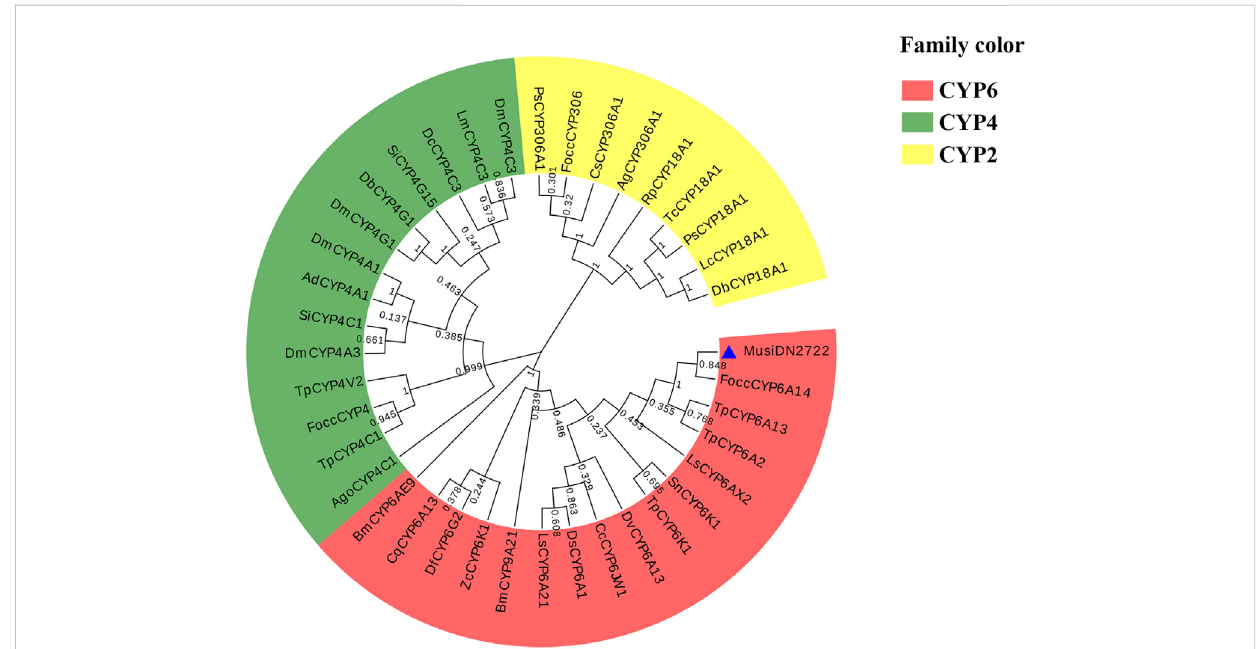
FIGURE 5 Phylogenetic analysis of MusiDN2722 . Focc, Frankliniella occidentalis ; Tp, Thrips palmi ; Sn, Schistocerca nitens ; Cc, Ceratitis capitata ; Ls, Laodelphax striatellus ; Dv, Diabrotica virgifera ; Bm, Bombyx mori ; Ds, Drosophila simulans ; Df, Drosophila fi cusphila ; Zc, Zerene cesonia ; Cq, Culex quinquefasciatus ;Ls, Luciliasericata ;Bm, Bombyxmori ;Tc, Triboliumcastaneum ;Lc, Luciliacuprina ;Rp, Rhopalosiphumpadi ;Cs, Chilosuppressalis ;Ps, Phyllotreta striolata ; Ag, Anopheles gambiae ; Db, Drosophila busckii ; Ad, Anopheles darlingi ; Dm, Drosophila melanogaster ; Si, Solenopsis invicta ; Lm, Locusta migratoria ; Dc, Diaphorina citri ; Ago, Aphis gossypii .